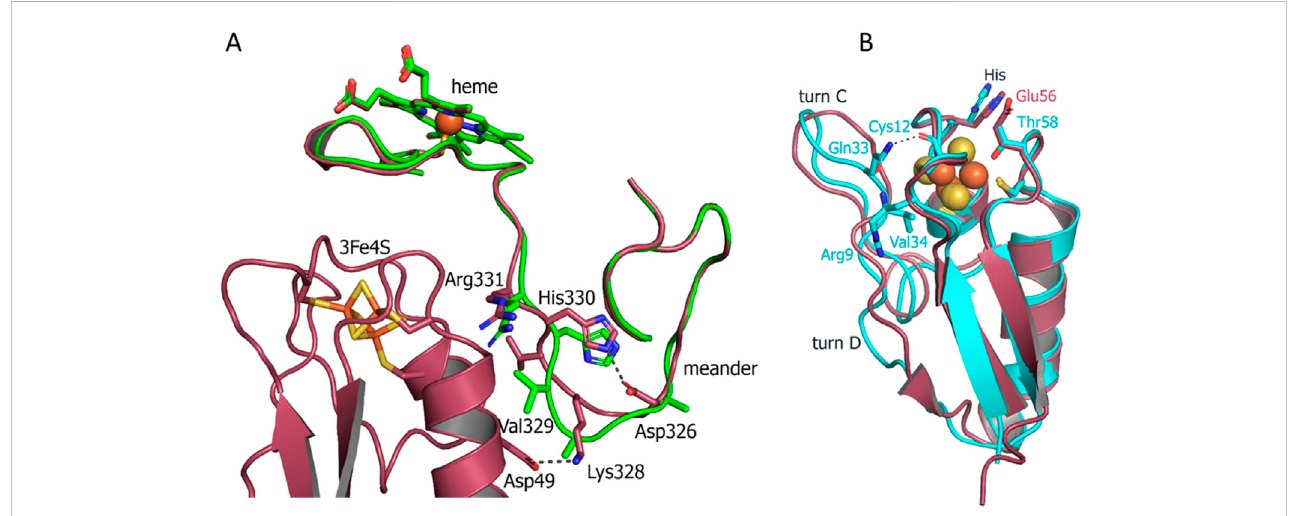
FIGURE 5 (A) SuperpositionoftheCYP143structurealone(greenribbon)withthestructureoftheFdxE − CYP143complex(raspberry)detailingthemeanderregion. (B) Superposition of Fdx (cyan) and FdxE